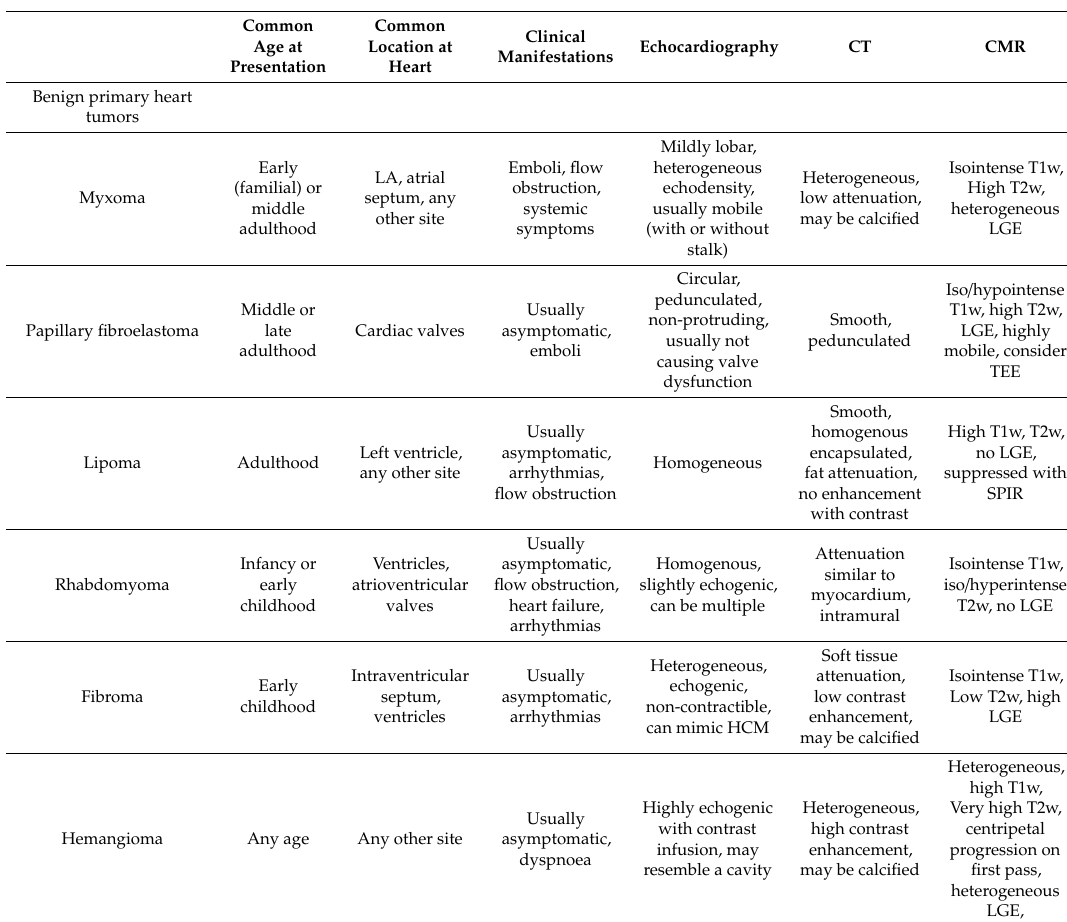
Table 1. Clinical, echocardiographic and cardiac magnetic resonance (CMR) characteristics of cardiac